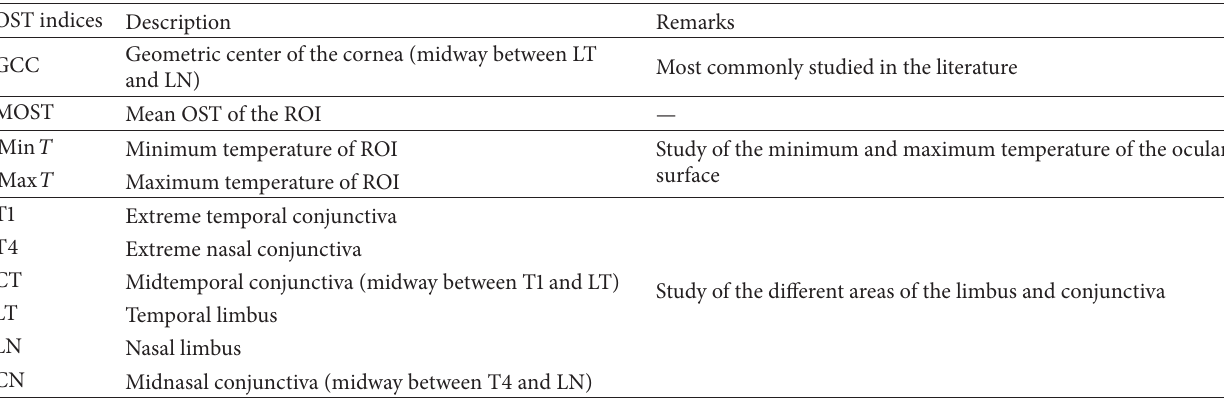
Figure 1: Ocular surface marking and OST acquisition using the novel “diamond” method. Table 2: The ten OST indices